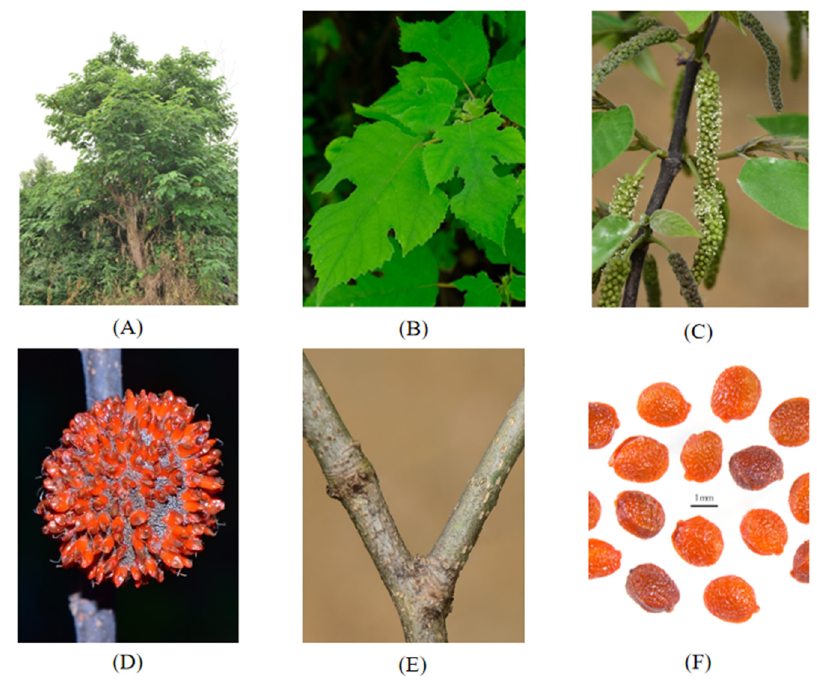
Figure 2. Broussonetia kazinoki Siebold. Images A–F show, respectively: the whole plant ( A ), leaves ( B ), flowers ( C ), fruits ( D ), twigs ( E ) and seeds ( F ) of Broussonetia kazinoki Siebold. According to the publication, Flora of China [12], the morphology of the genus is described thus: “Trees or shrubs, or vine-like shrubs; there is emulsion, and the winter buds are small. Leaves are alternate, split or non-divided, with serrated margins, basal